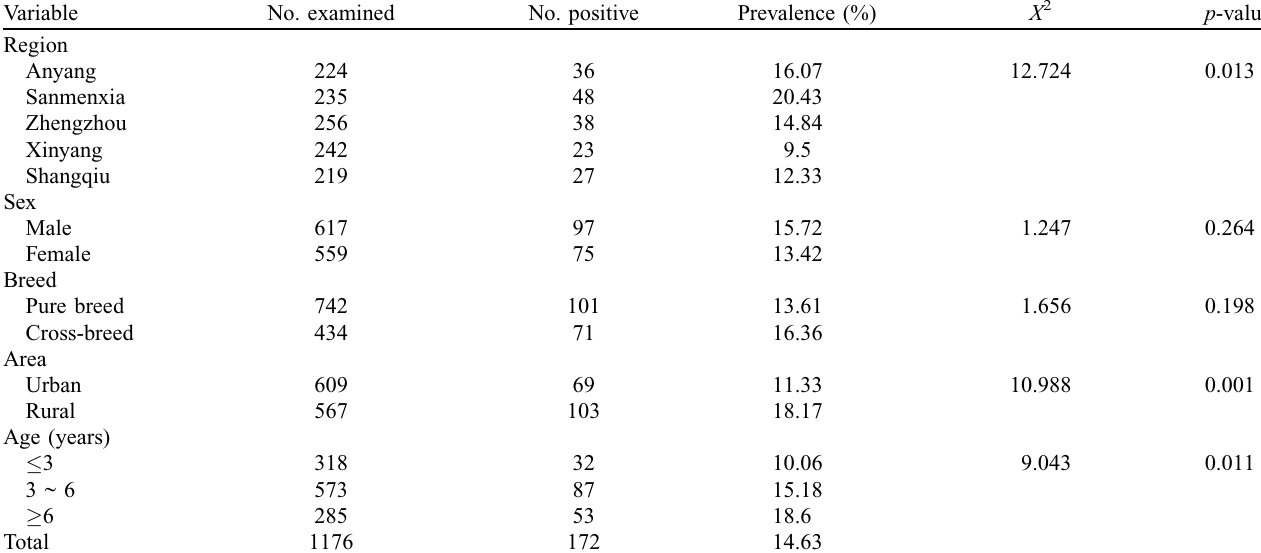
Table 2. Seroprevalence of Neospora caninum infection in dogs in Henan province, central China. Variable No. examined No. positive